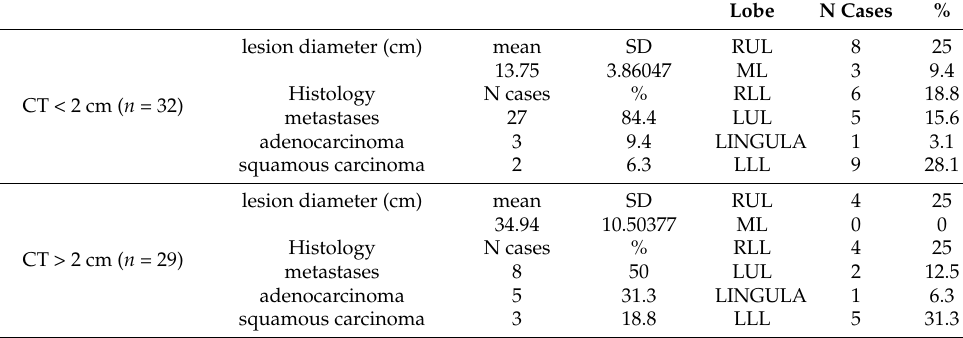
Table 1. Displaying the mean maximum diameter, histology and localization of lesions for each group (RUL = right upper lobe, ML = medial lobe, RLL = right lower lobe, LUL = left upper lobe, LLL = left lower